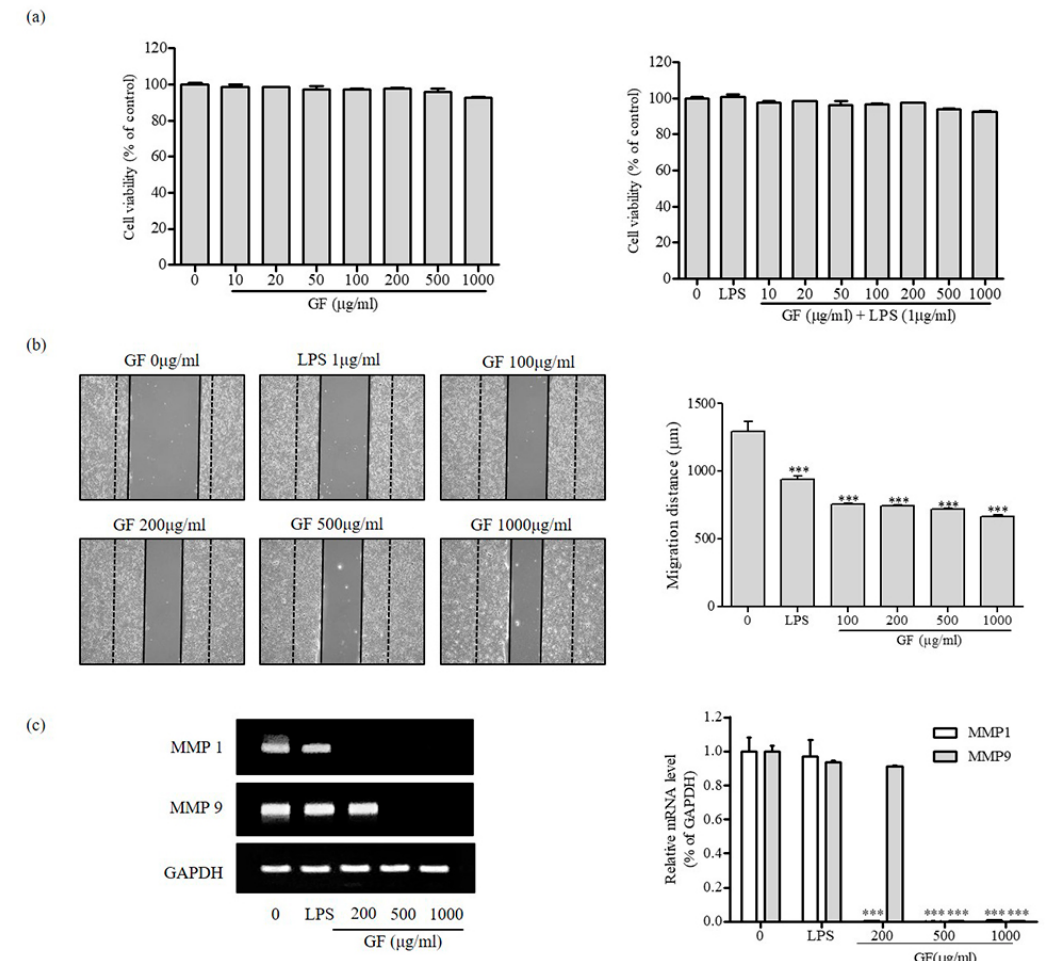
Figure 3. GF inhibited matrix metalloproteinase (MMP) mRNA expression and exhibited migration ability in human keratinocyte HaCaT cells. ( a ) HaCaT cells were treated with various concentrations of GF (10–1000 µ g / ml) for 24 h after vehicle (upper panel) or LPS (1 µ g / ml) (lower panel) pretreatment for 1 h (upper panel). After treatment, cell viability was measured using a WST-1 assay. ( b ) The migration ability of HaCaT cells was observed using an optical microscope, and photographs were obtained. HaCaT cells were treated with concentrations of GF (100, 200, 500, and 1000 µ g / ml) and LPS (1 µ g / ml). The bar graphs represent the quantitation of migration distance data. ( c ) The MMP-1 and MMP-9 mRNA levels were measured by RT-PCR analysis in HaCaT cells. The bar graphs represent the quantitation of RT-PCR data. The absorbance was measured by an ImageJ. GAPDH was used as an internal control. Data are presented as mean ± SEM. *** p < 0.001 compared to nonstimulated cells (GF 0 µ g / ml).